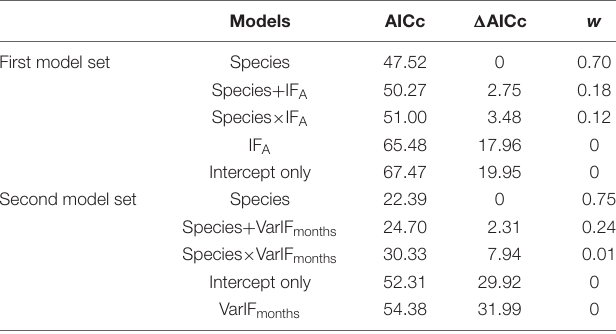
TABLE 4 | Values of the Akaike information criterion adjusted for small sample sizes (AICc), differences in AICc with respect to the best-fitting model ( (cid:49) AICc), and Akaike weights ( w ) for competing models that examined variation in the MI per